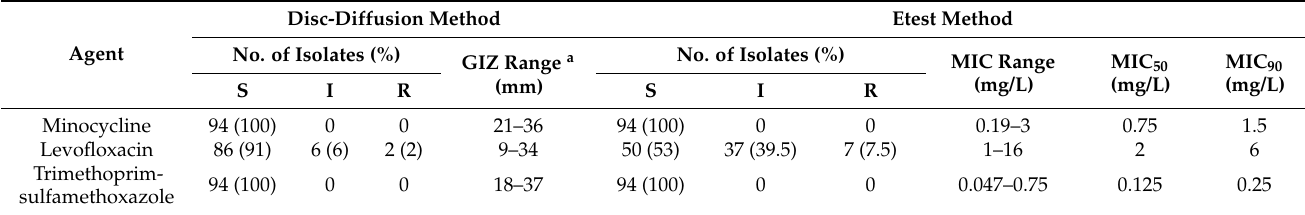
Table 2. The drug susceptibility of S. maltophilia clinical isolates ( n = 94). Disc-Diffusion Agent